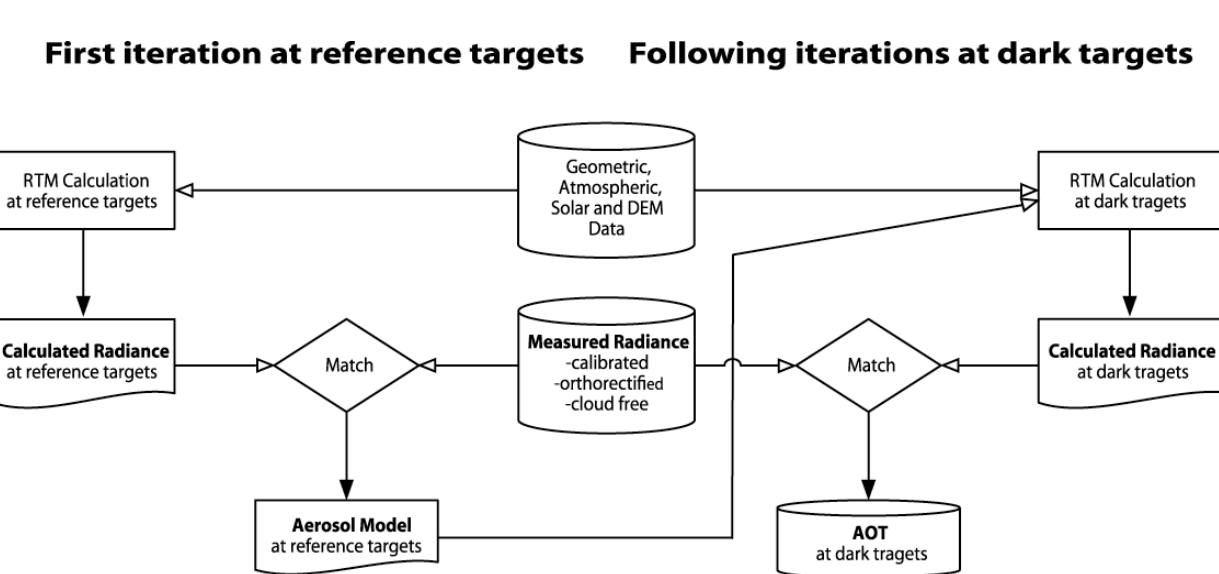
Figure 10. Aerosol retrieval algorithm flowchart. A first iteration is carried out at reference target pixels with a known spectral surface reflectance. This helps to constrain the unknown variables and to find the appropriate aerosol model. The following iterations continue with this aerosol model and retrieve AOD at dark pixels, where the influence of the error in surface reflectance is relatively